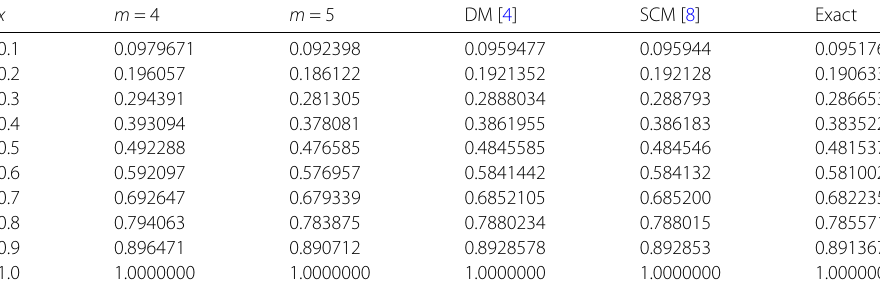
Table 2 Approximated solutions utilizing approach II for λ = 0.5